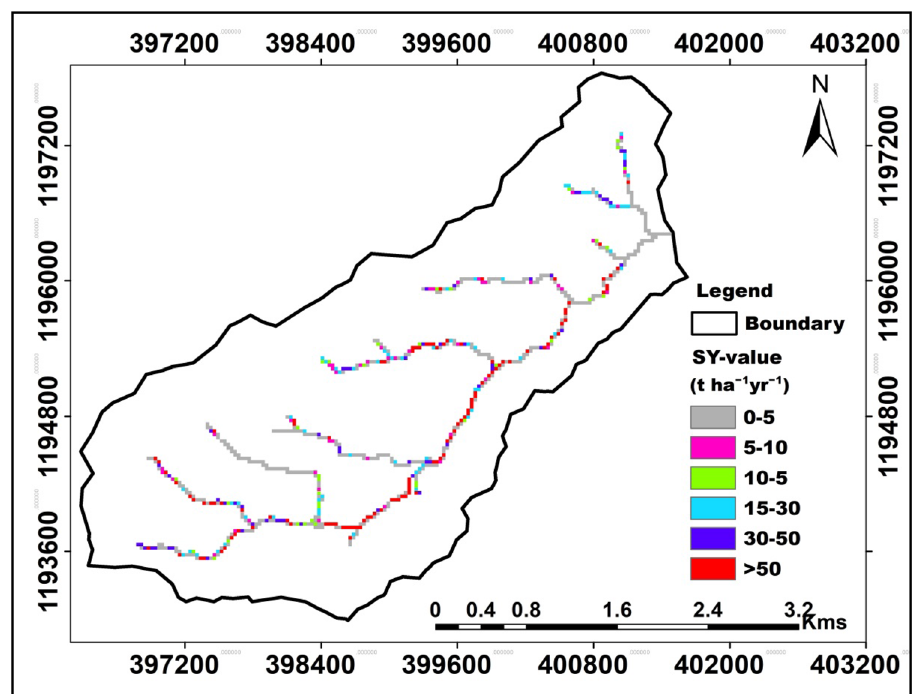
Fig. 9 Map of sediment yield in the